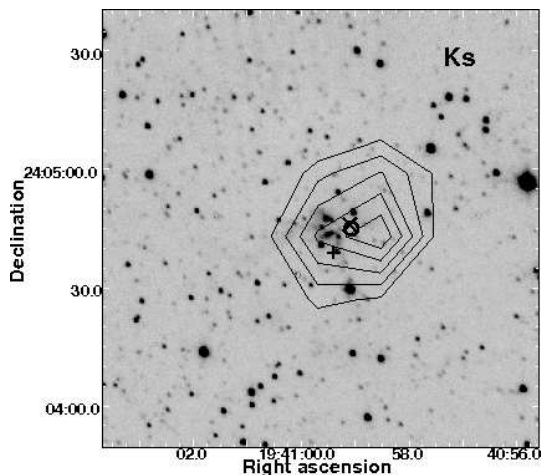
Figure 1: Ks-band image of IRAS19388+23657. The plus indicates the position of the IRAS source, while the open circle and the cross give the positions of the 6cm radio continuum and the MSX source respectively. The contours represent the 1.2mm